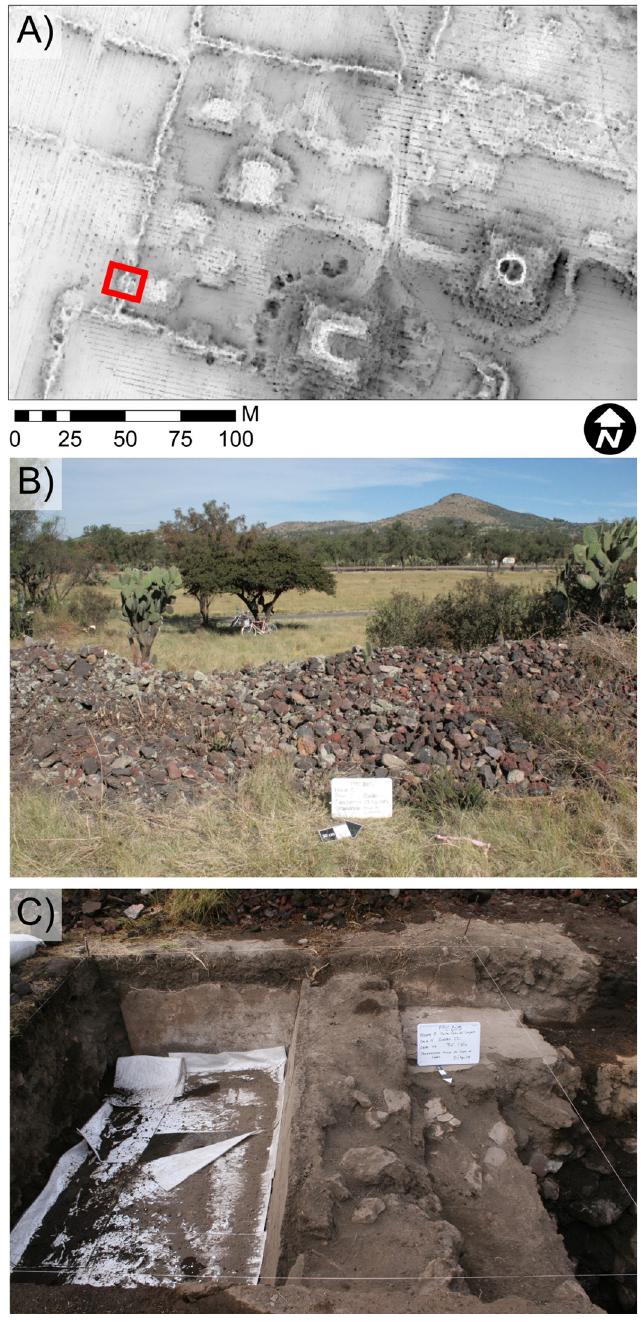
Fig 6. Images pertaining a modern rock pile. A) Sky-view factor image of Plaza of the Columns showing a modern rockpile delineating the complex, rectangle indicates excavation unit along a Teo Modern alignment, B) photograph of the modern rock pile, C) photograph of excavations revealing large wall beneath modern rock pile. Published under a CC BY license, with permission from N. Sugiyama, original copyright Project Plaza of the Columns Complex